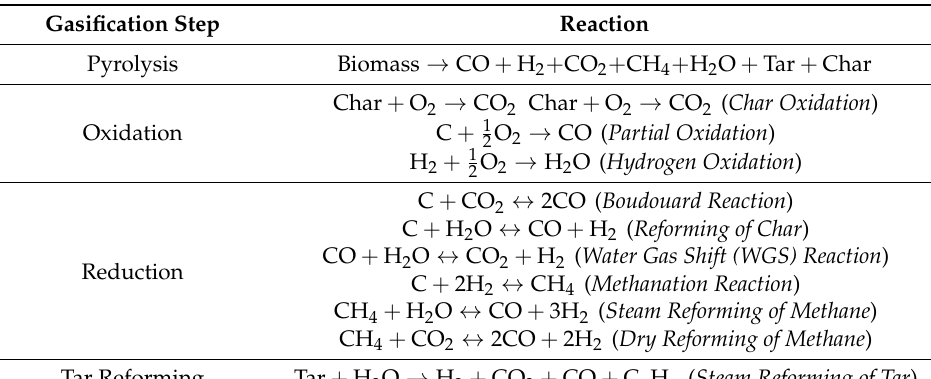
Table 1. Main reactions of the gasification process.